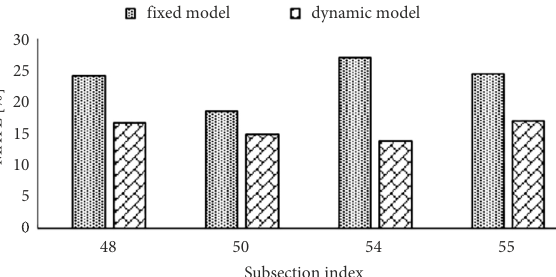
Figure 11. MAPE comparison between fixed and dynamic models in rainy days